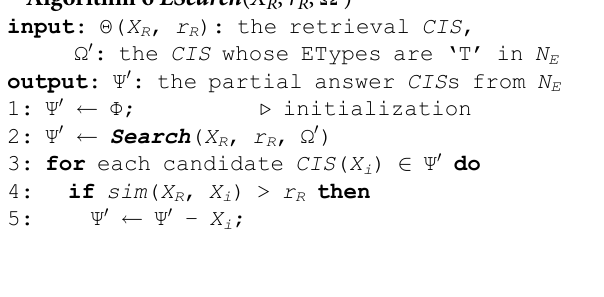
Algorithm 6 ESearch ( X